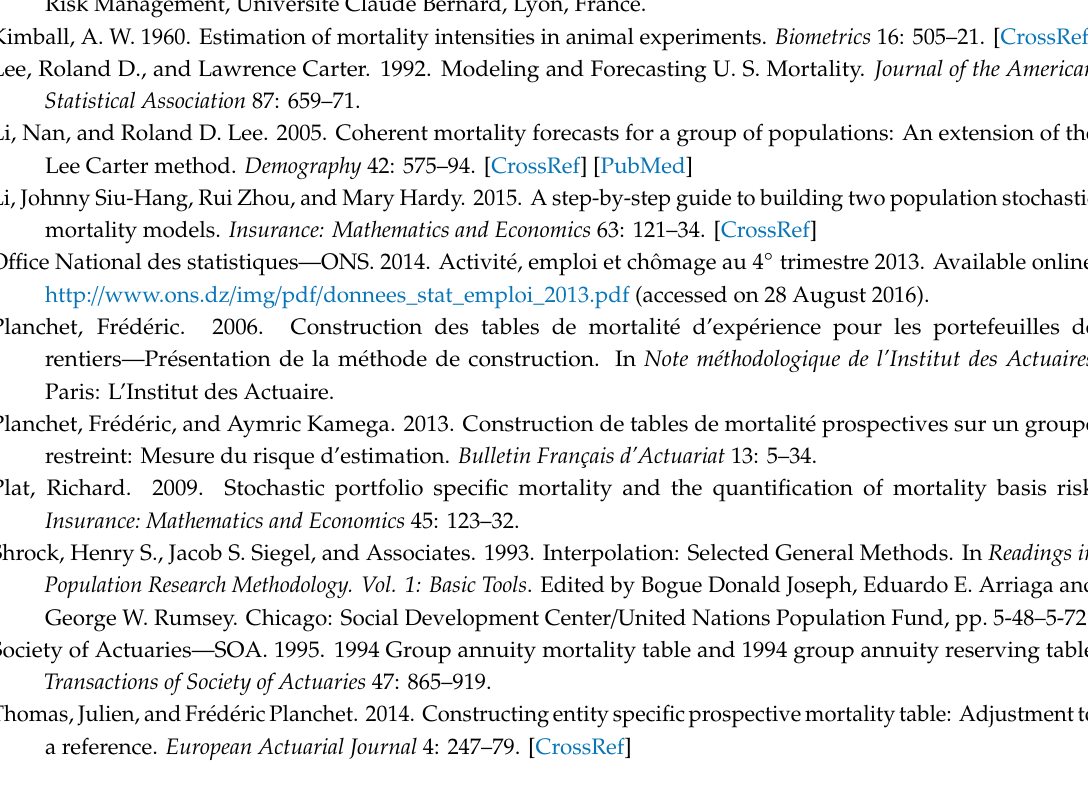
O ffi ce National des statistiques—ONS. 2014. Activit é , emploi et ch ô mage au 4 ◦ trimestre 2013. Available online: http: // www.ons.dz / img / pdf / donnees_stat_emploi_2013.pdf (accessed on 28 August 2016). Planchet, Fr é d é